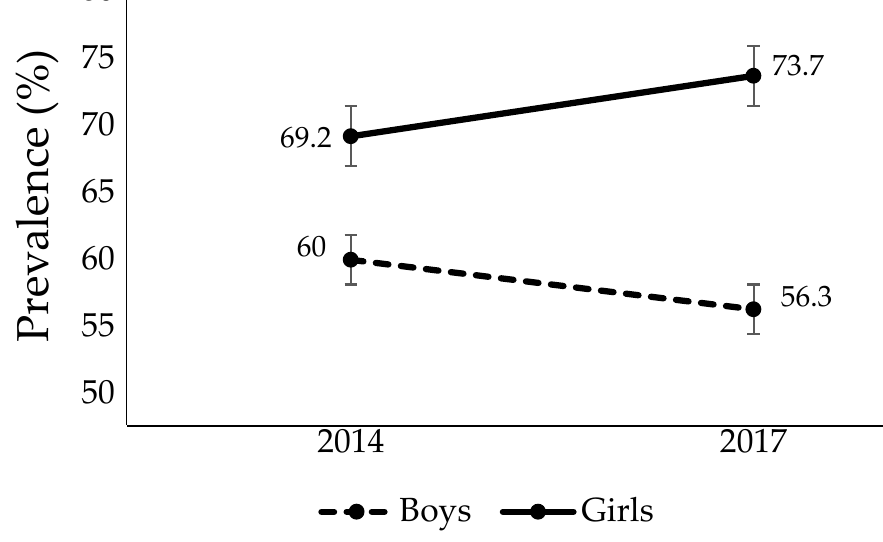
Figure 2. Back pain prevalence among boys and girls in 2014 and 2017.